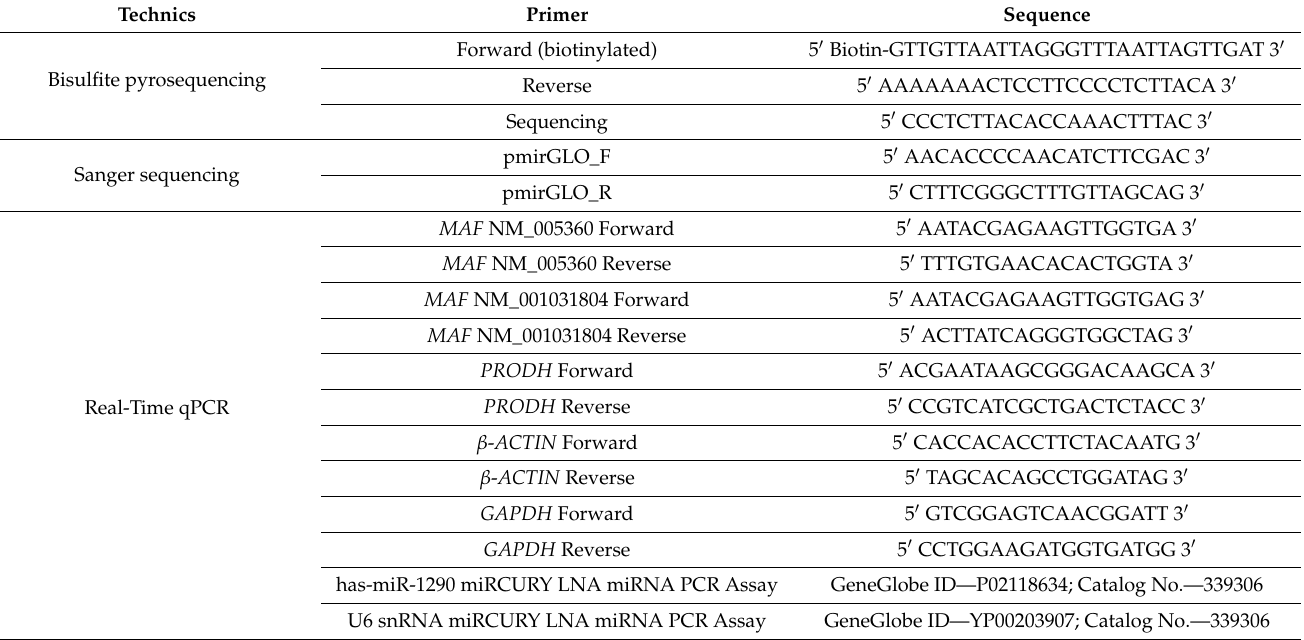
Table 3. Primer sequences used in the